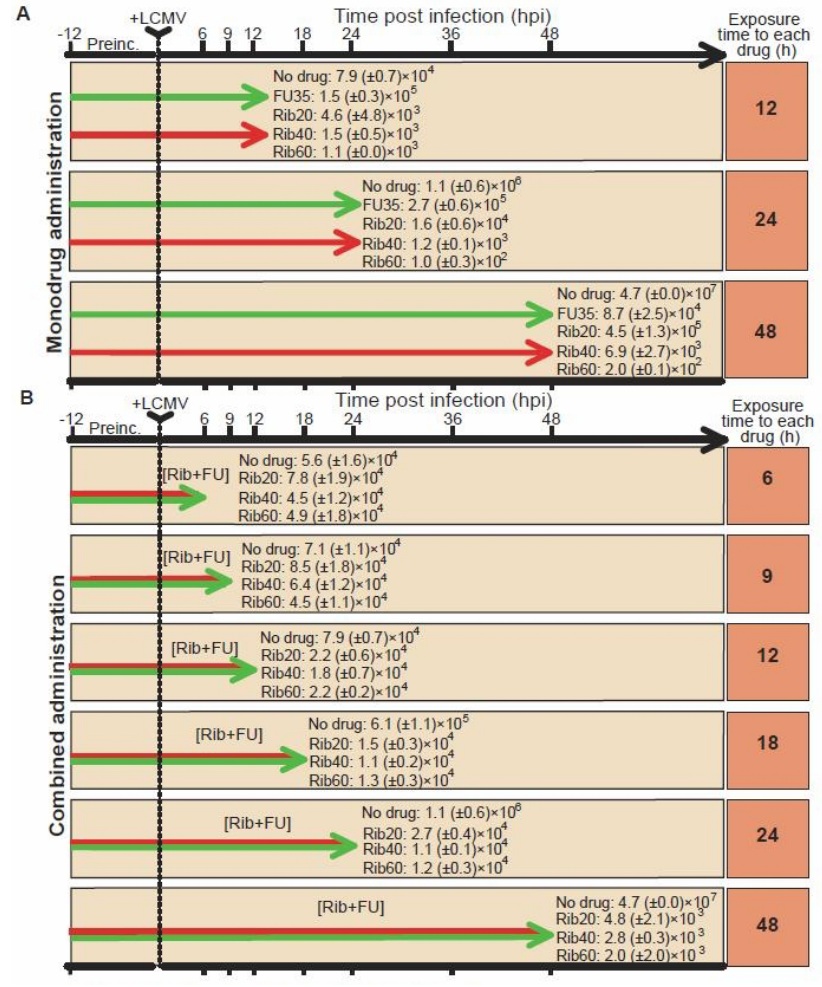
Figure 1. Find panel C in the next